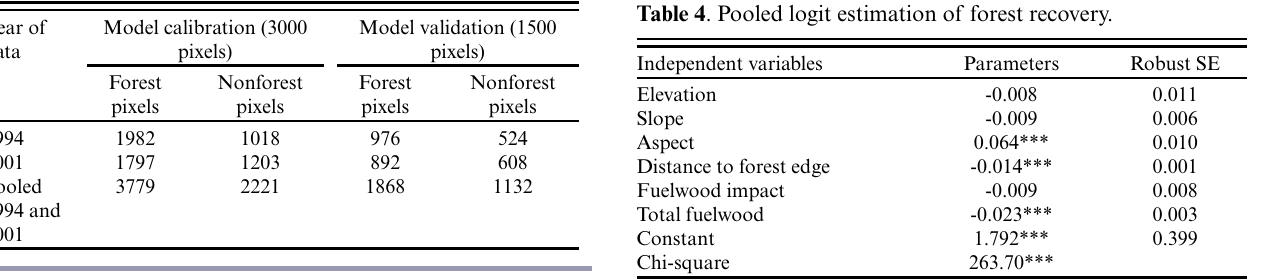
Table 2 . Summary of data for the calibration and validation of forest loss and recovery models.